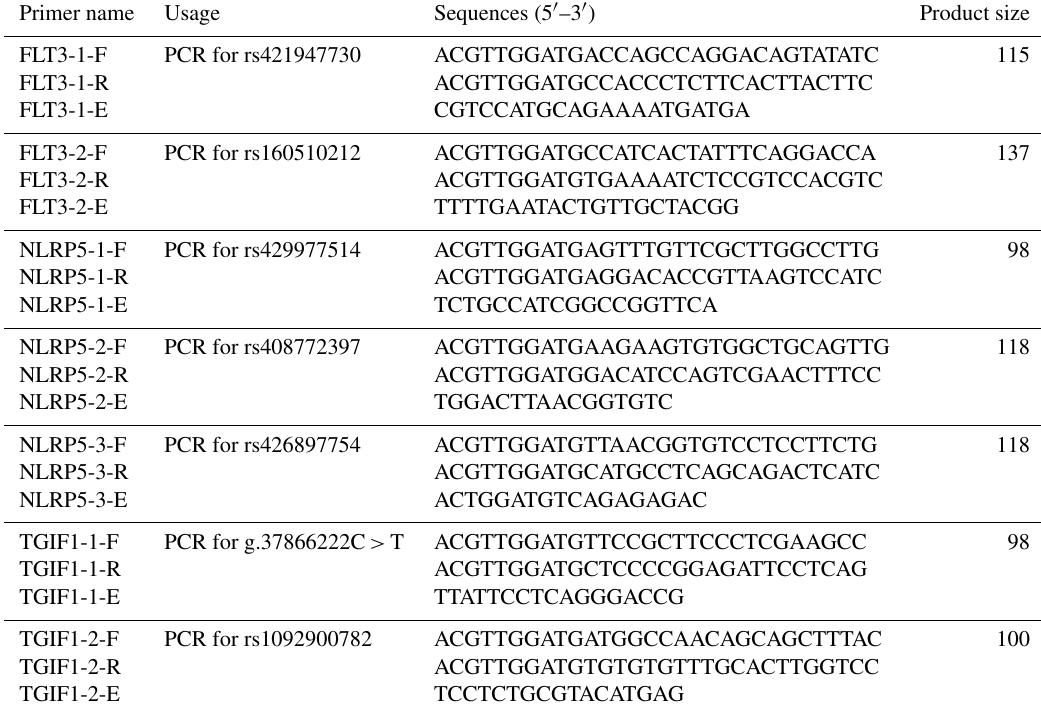
Table 2. Primer information for seven